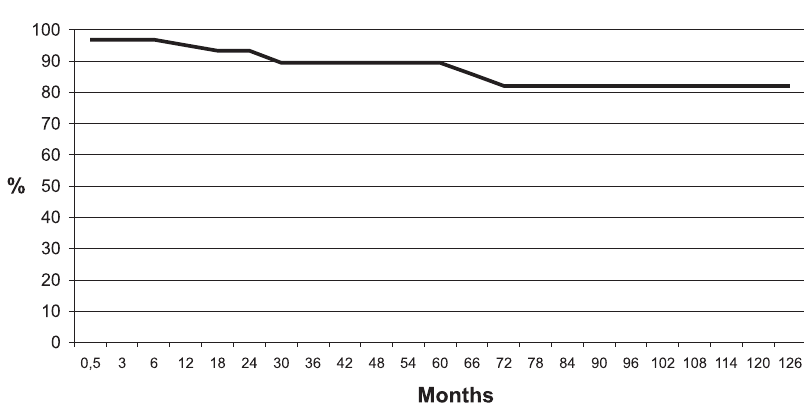
02.pmd 27/5/2005,